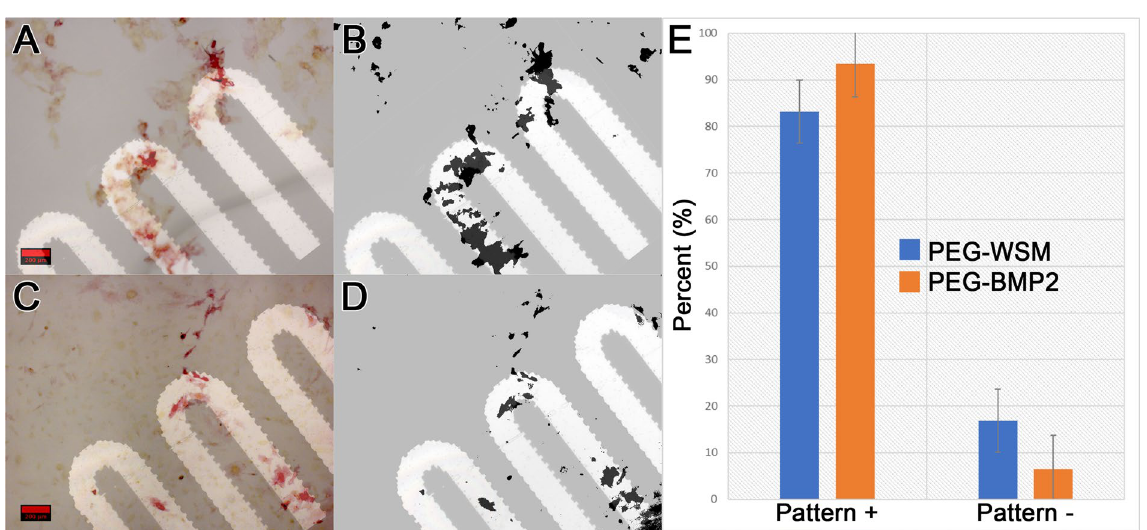
Figure 8. ALP-stained images of PEGDA hydrogels incorporating patterned PEGylated WSM ( A ) and BMP2 ( C ) were thresholded for intensity and overlaid with pattern ( B , D ). Mineralization associated with the overlaid patterns were quantified ( D ). Graph indicates percentage of stained cells associated with patterned PEGylated WSM. Scale bars are 100 µm. Error bars represent standard Acellular mineralization studies revealed that PEGylating nacre proteins increased submicron mineralization while PEGylating bone proteins decreased submicron mineralization. In particular, PEG-WSM proteins increased mineralization on the sub-micron scale more than all other PEGylated proteins. Because PEG-WSM was the only protein capable of controlling both acellular and cell-mediated mineralization, the sub-micron features observed may be key to achieving this control. This increased presence of sub-micron mineralization on slides